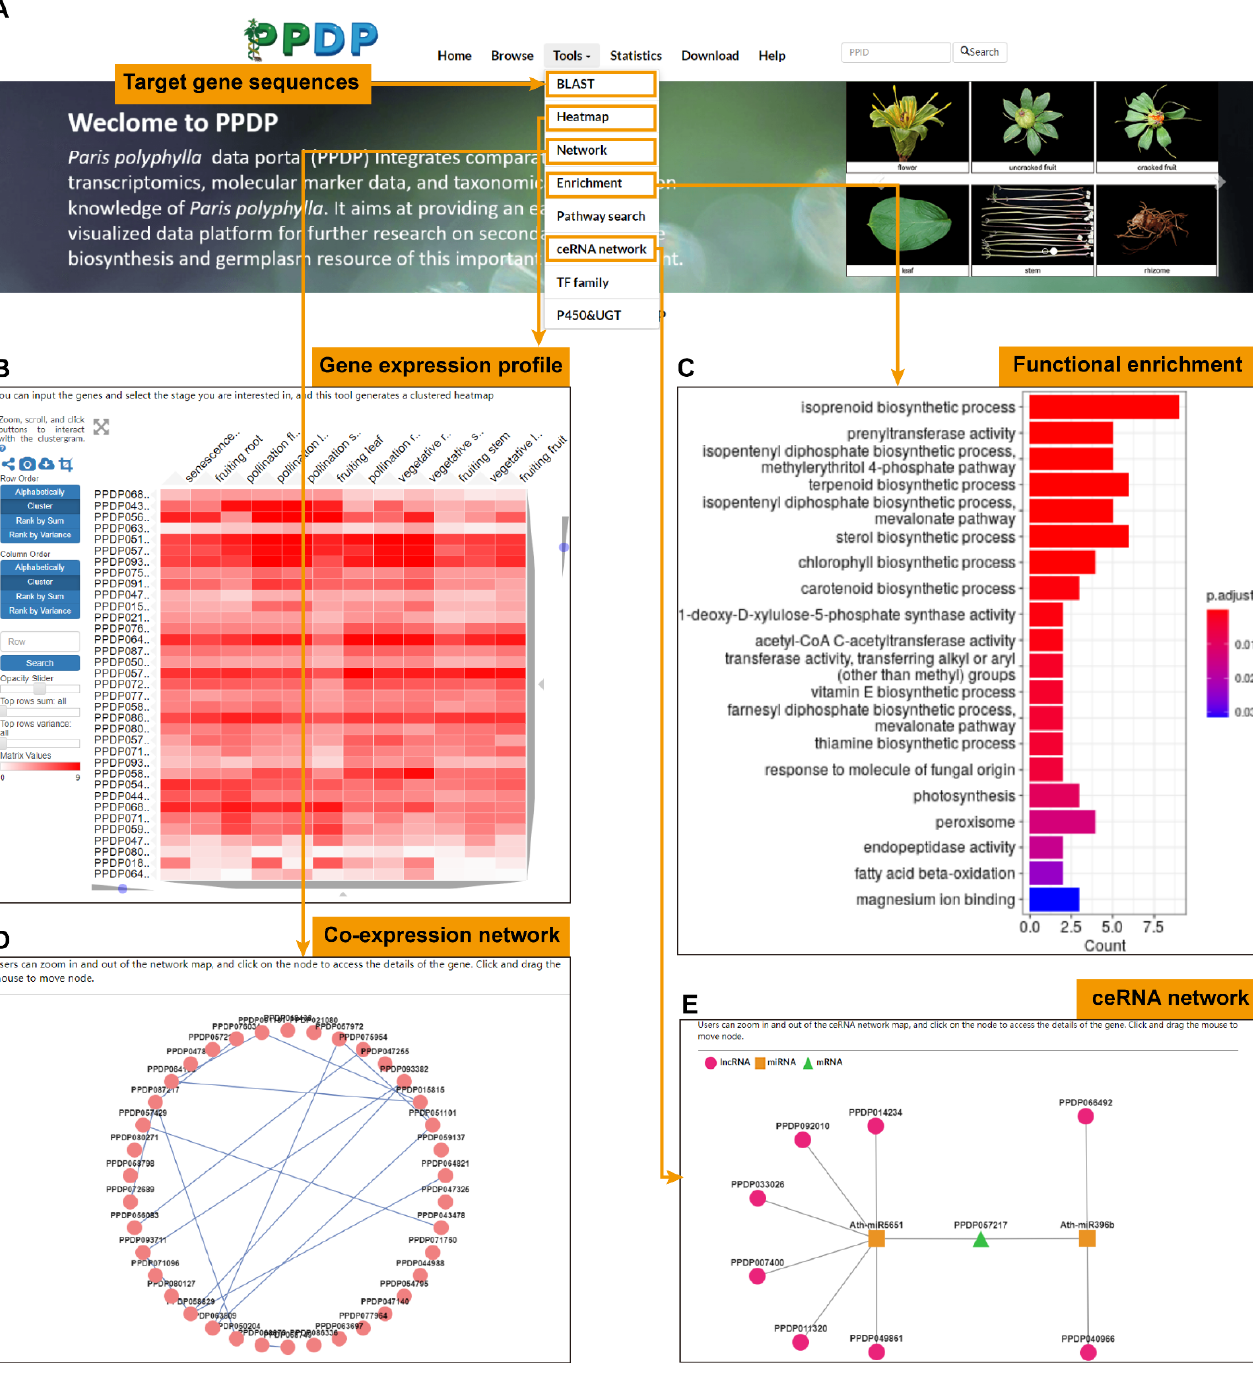
Figure 6. Case study: gene function prediction using PPDP tools. ( A ) Interface of tools in PPDP. ( B ) Heatmap of polyphyllin backbone biosynthesis ‐ related genes in P. polyphylla . ( C ) Sub ‐ network of predicted genes related to the biosynthesis. ( D ) GO enrichment of predicted genes related to biosynthesis. ( E ) CeRNA network of polyphyllin backbone biosynthesis ‐ related gene candidates. Tri ‐ angles represent miRNAs, squares represent mRNAs, and circles represent lncRNAs.